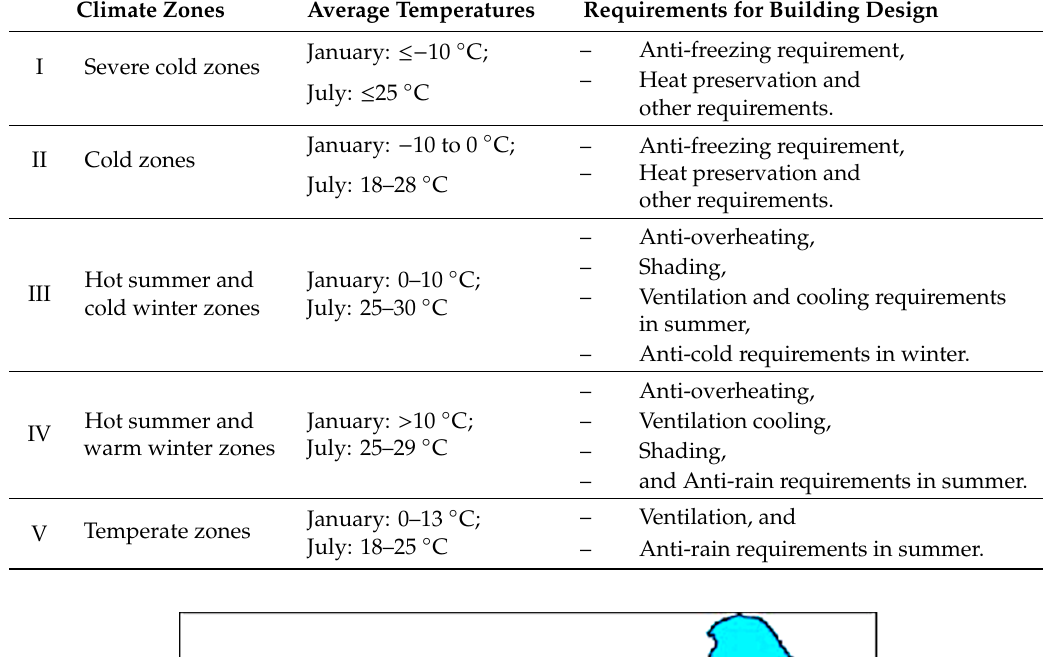
Table 2. Climate zones, characteristics and building design requirements in China [30].